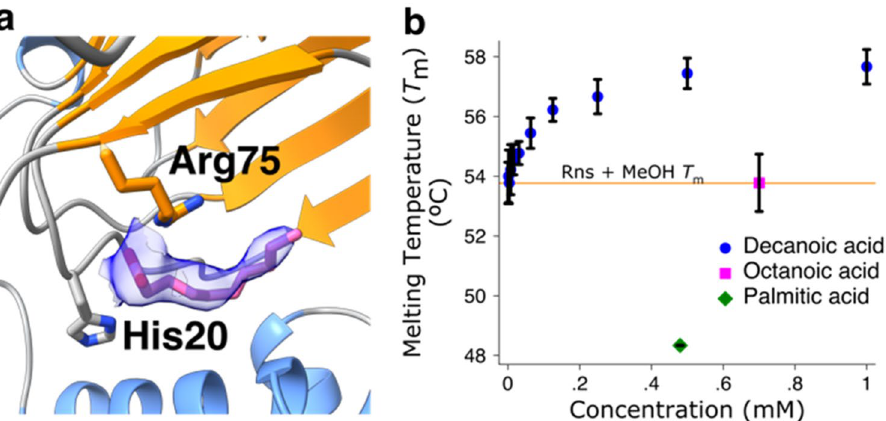
Figure 3. Rns binds decanoic acid. ( a ) Detail showing the electron density from an 2Fo-Fc omit map contoured to 1σ around the decanoic acid as a blue volume. Image created with ChimeraX 38 . ( b ) DSF showing an increase in the T m of Rns in a dose dependent manner with decanoic acid. Octanoic acid does not affect the T m of Rns and palmitic acid decreases the melting temperature of Rns. Data is shown as the mean ± SD, n =